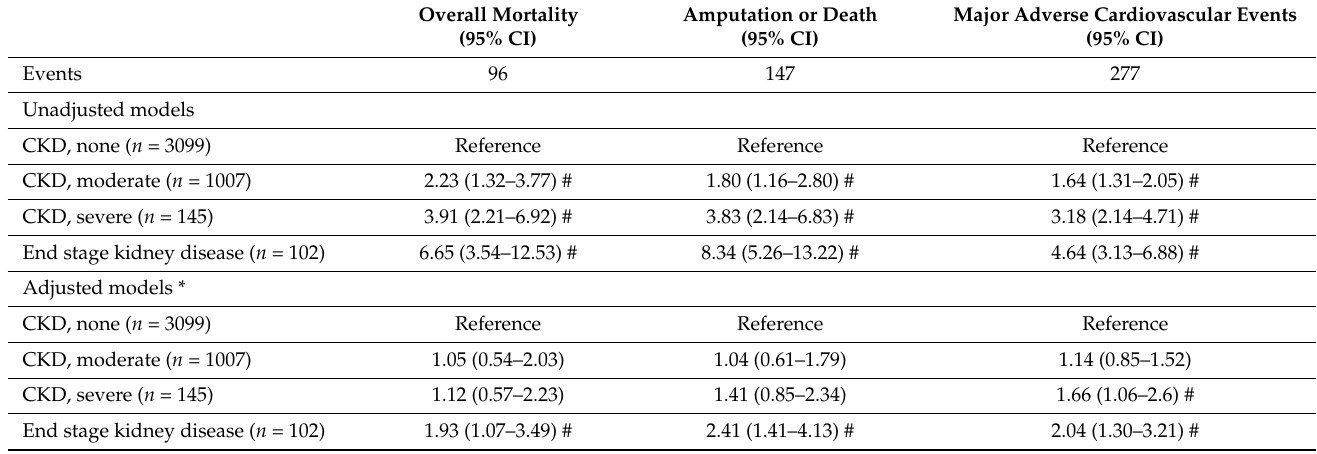
Table 3. Association between severity of CKD and 12-month overall mortality, amputation or death, and major adverse cardiovascular events. Estimates were extracted from five imputed datasets with ten iterations each and combined using Rubin’s rules. CKD: Chronic kidney disease, CI: Confidence interval. * Models adjusted for age, Fontaine stage, sex, procedure type, smoking status, ambulatory impairment, obesity, self-rated health, employment status, ASA (American Society of Anesthesiologists) classification, prior coronary revascularisation, prior peripheral revascularisation, diabetes, chronic heart failure, lipid-lowering drugs, antiplatelets with cluster-robust standard errors for medical centre. # denotes statistical